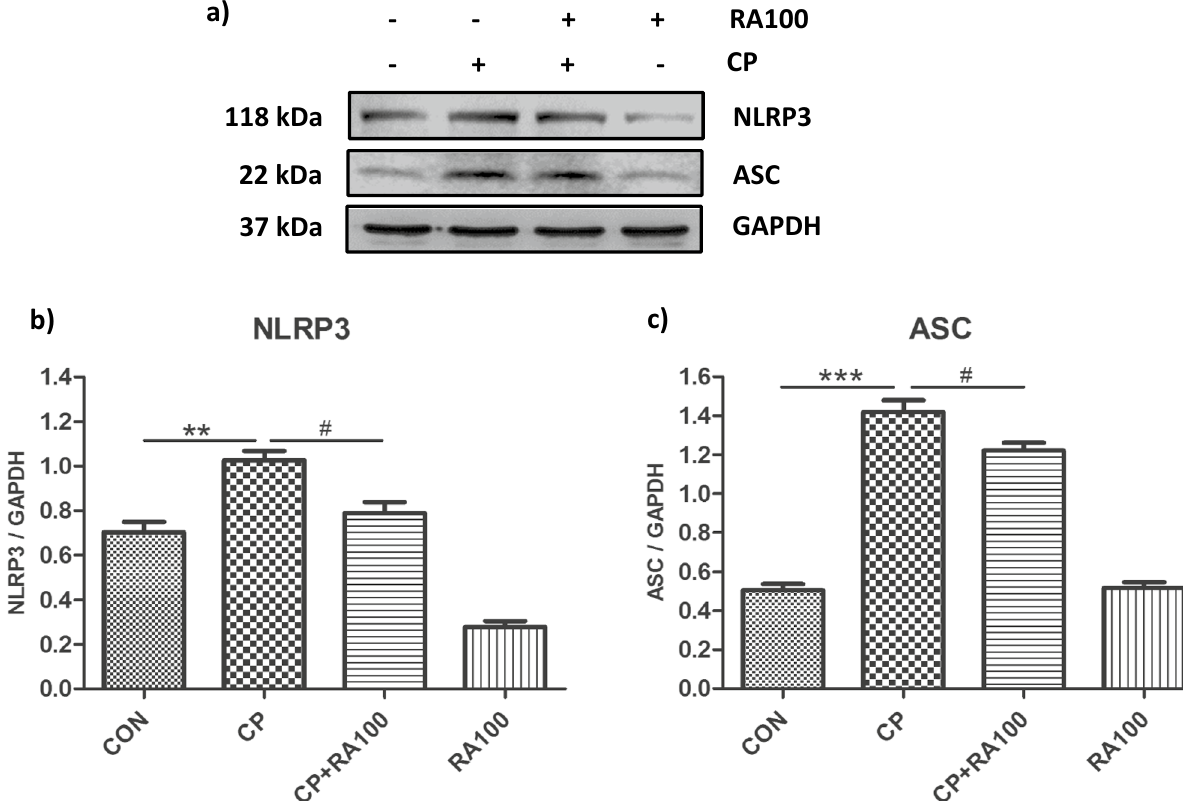
Figure 4. Western blot analysis and densitometric quantification of hallmarks of NLRP3 inflammasome activation, NLRP3 and ASC proteins in the mouse kidney treated with CP and RA. ( a ) Represents the immunoblots of NLRP3 and ASC proteins in CP and RA treatments in mouse kidney. The administration of CP at the dose of 20 mg/kg b.wt. caused an increase in the expression of NLRP3 and ASC proteins when compared with control group of animals. While the treatment with the dose of 100 mg/kg b.wt. of RA along with CP caused a decrease in the expression of NLRP3 and ASC proteins when compared with CP alone treated group of mice. In this figure histogram ( b ) and ( c ) represent significant differences between CP and CP + RA100 treated group of animals. The treatment of CP caused a significant increase in the expression of NLRP3 (** p < 0.01) and ASC (*** p < 0.001) proteins when compared with control group of animals. However, the treatment of RA along with CP caused a significant restoration in the expression of NLRP3 ( # p < 0.05) and ASC ( # p < 0.05) proteins when compared with CP alone treated group of mice. No significant differences were noticed in RA alone treated group of animals when compared with the control group of animals. Data are expressed as means ± SEM ( n =